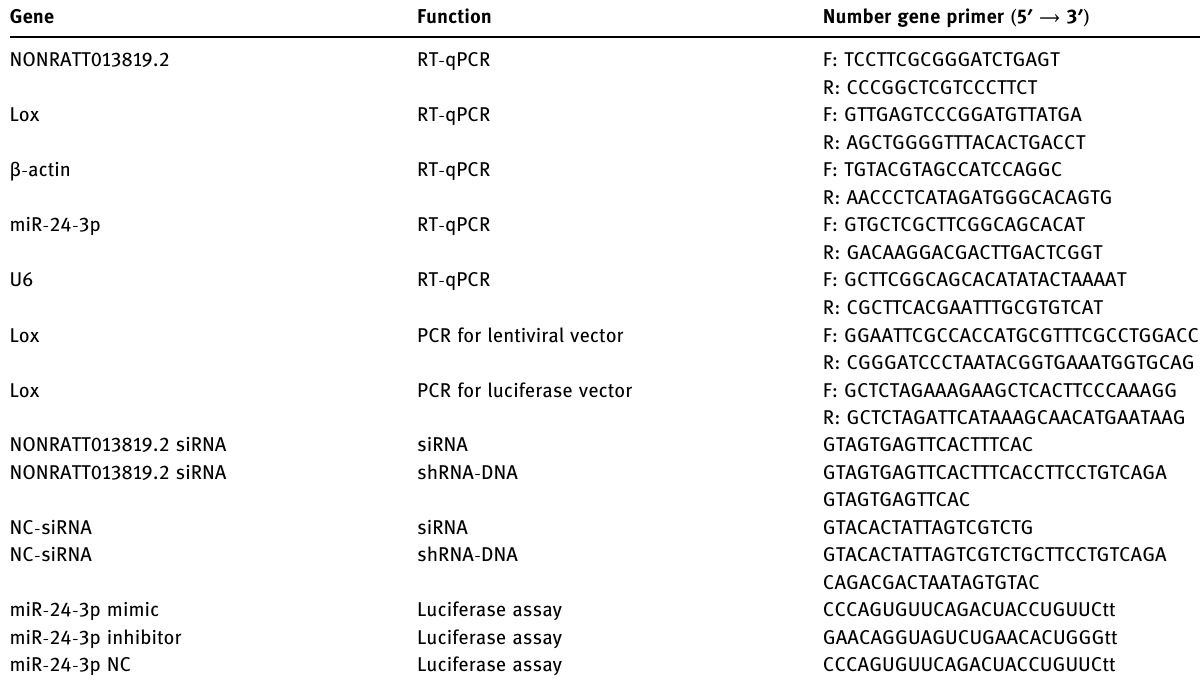
Table A1: Primers used in used in this study